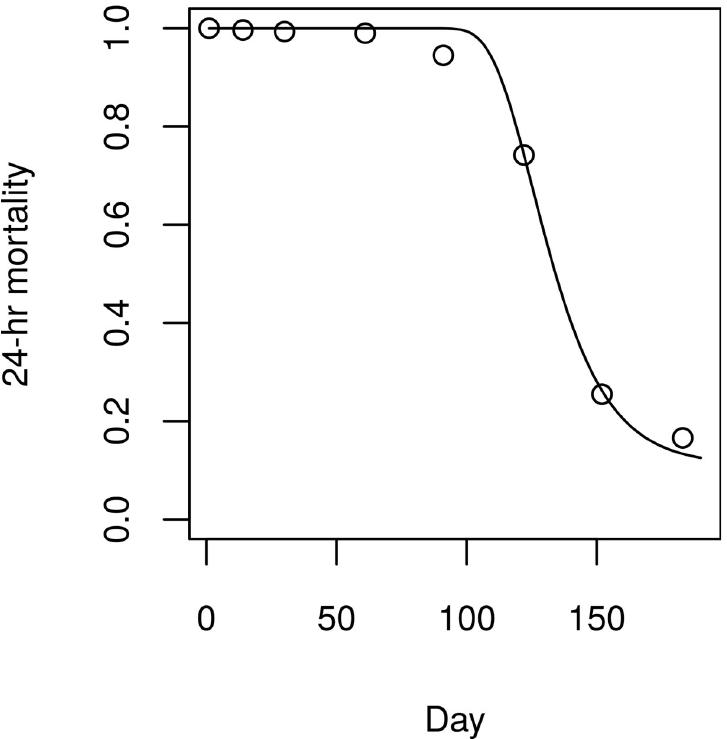
Fig 3. Mortality over time following TIRS spraying. Circles represent data from Dunbar et al. [25], line represents mortality function fitted by least squares (R 2 = 0.995).